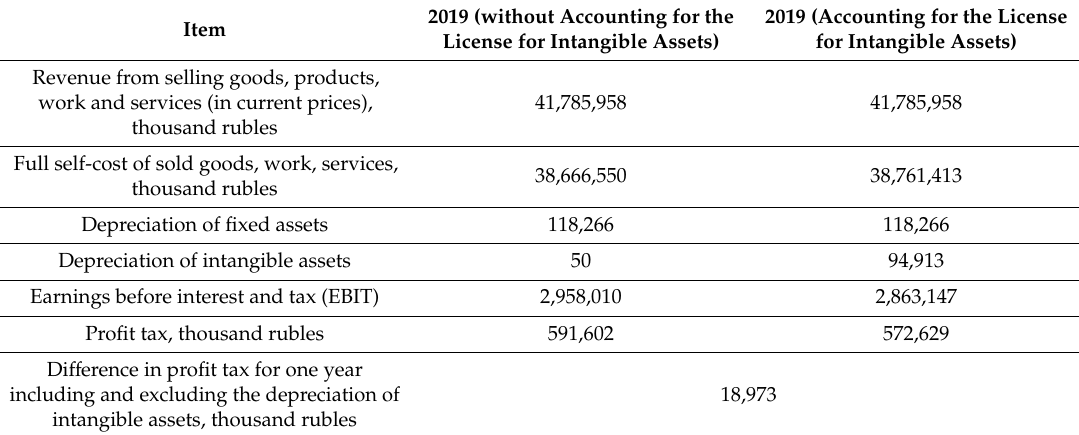
Table 5. The profit tax calculated prior to and after the intangible assets were accounted for and